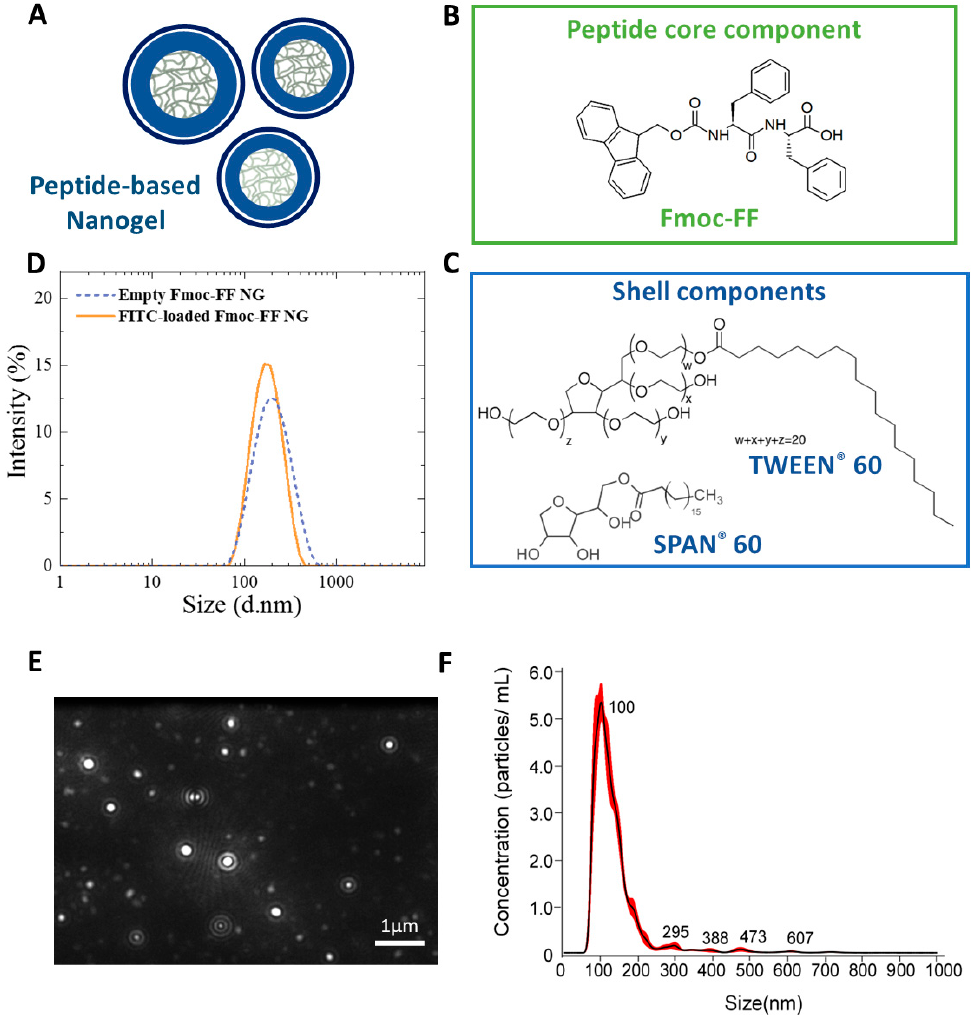
Figure 1. Graphical representation of nanogels and their structural characterization. ( A ) A schematic model of peptide nanogels; ( B )chemical formulas of the core peptide; ( C ) the shell components TWEEN ® 60 and SPAN ® 60; ( D ) Size distribution of the empty and filled-FITC loaded nanogels by DLS measurements; ( E ) A representative video frame of the Fmoc-FF nanogels; ( F ) Size distribution of particles using nanoparticle tracking analysis (NTA).